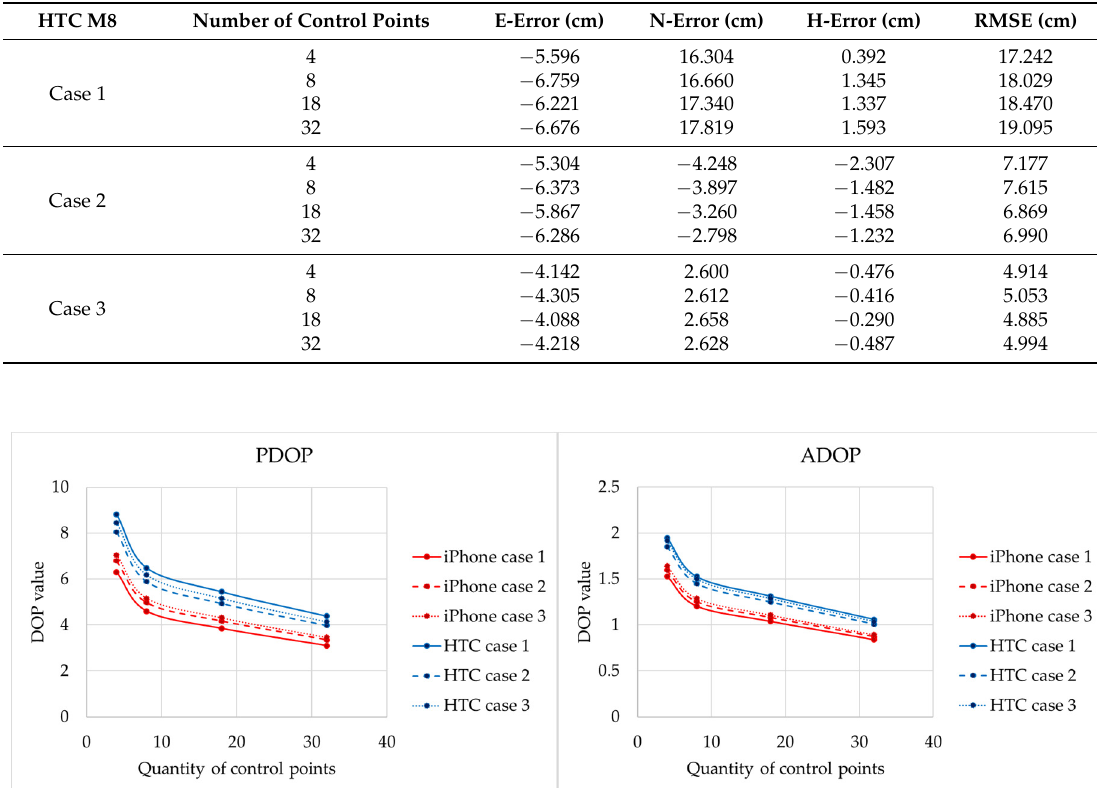
Table 5. The position error of quantity analysis for HTC M8.